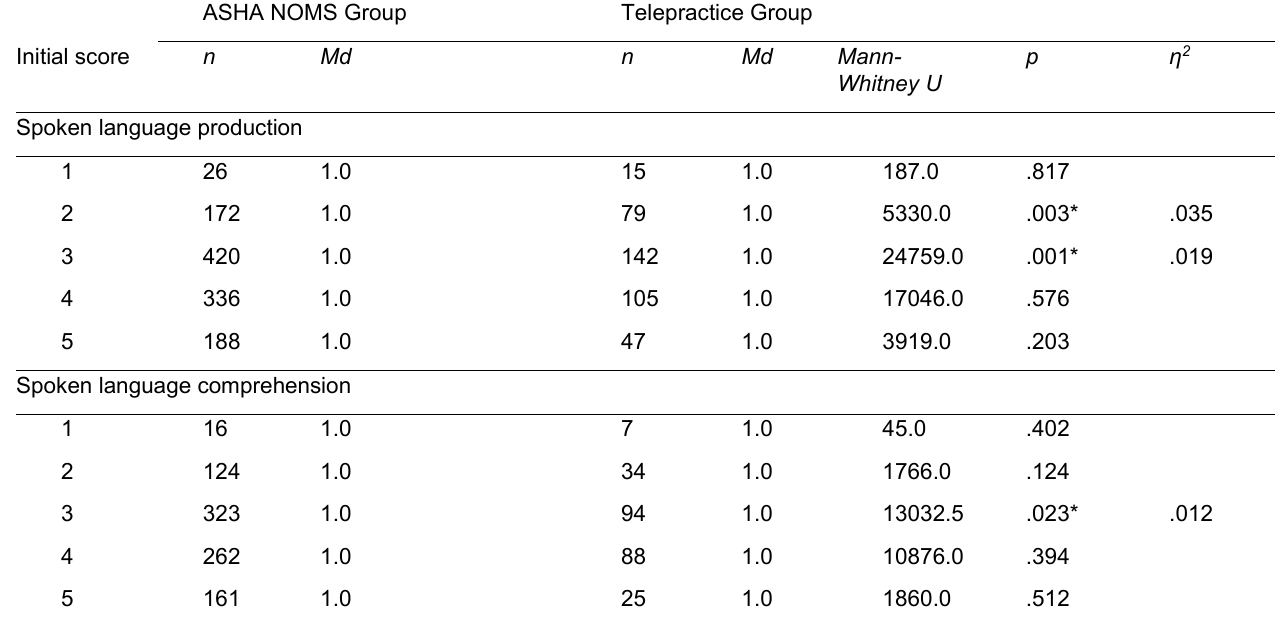
Median Difference Scores for Spoken Language Production and Spoken Language Comprehension by Initial FCM